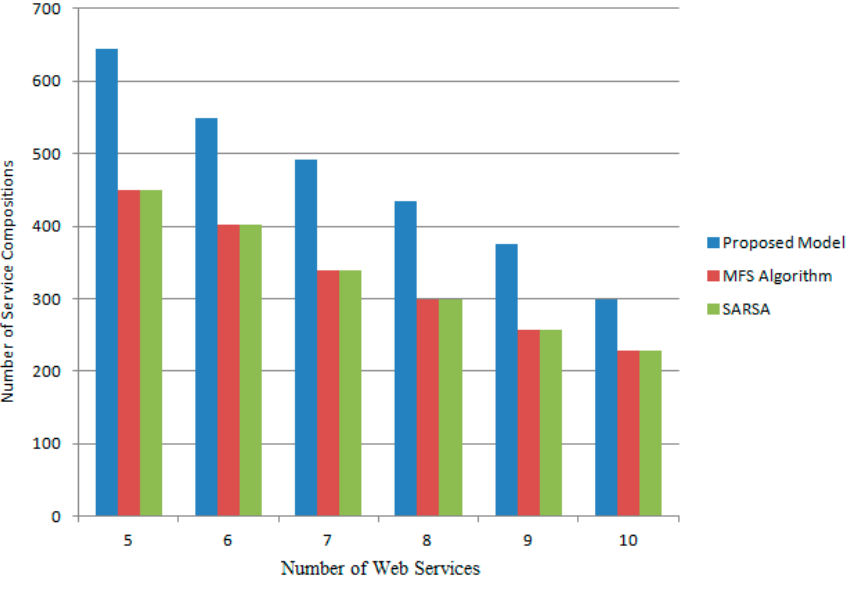
Figure 5. Number of constructed service compositions with composition threshold = 100.